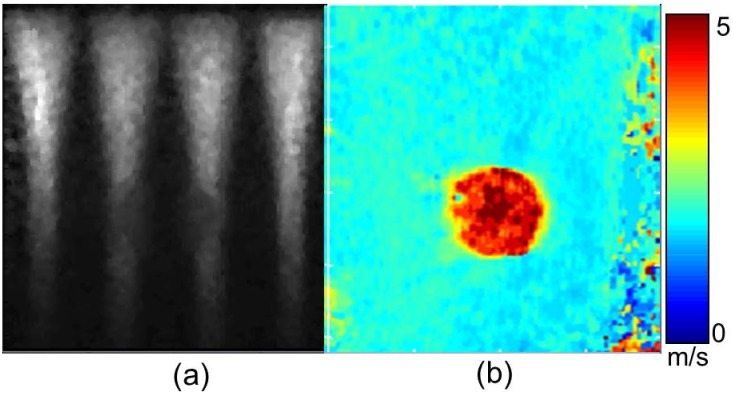
CUSE phantom study: (a) Acoustic radiation force excitation and (b) LR shear wave speed map.